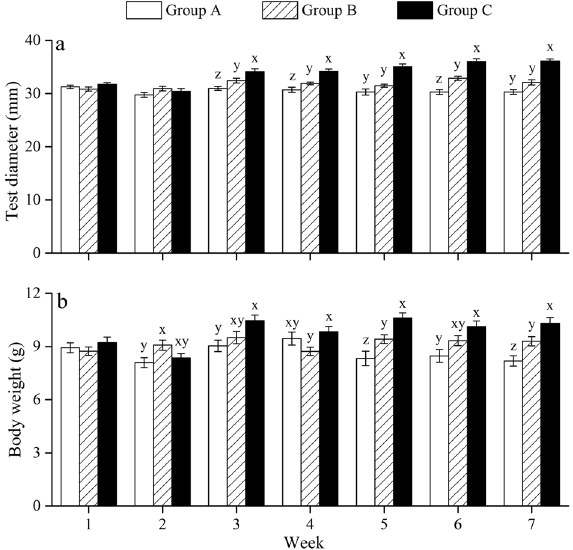
Figure 3. Test diameter ( a ) and wet body weight ( b ) of Strongylocentrotus intermedius of the experimental groups in 7 weeks (mean ± SD) (N = 8). Letters above the bars represent significance in each week ( P < 0.05).